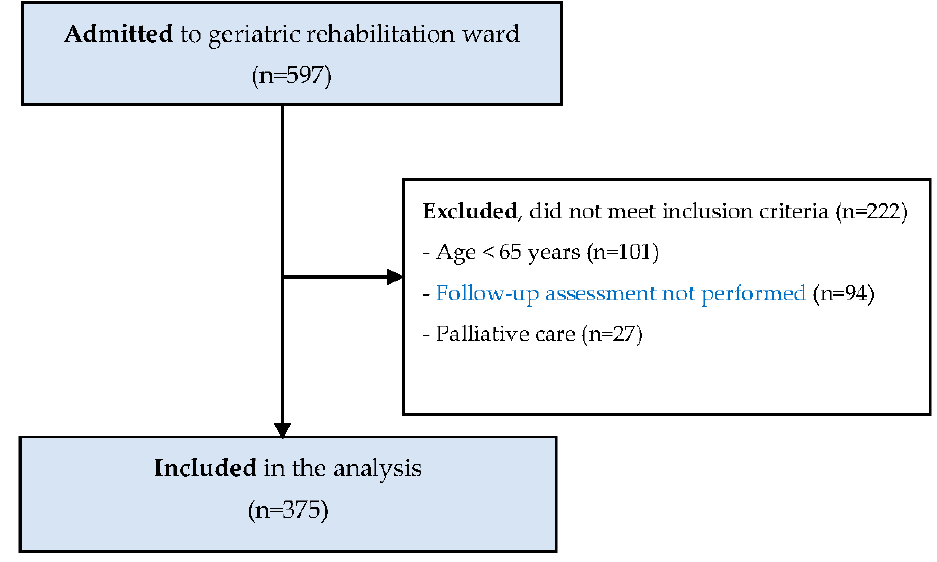
Figure 1. Study flow diagram.